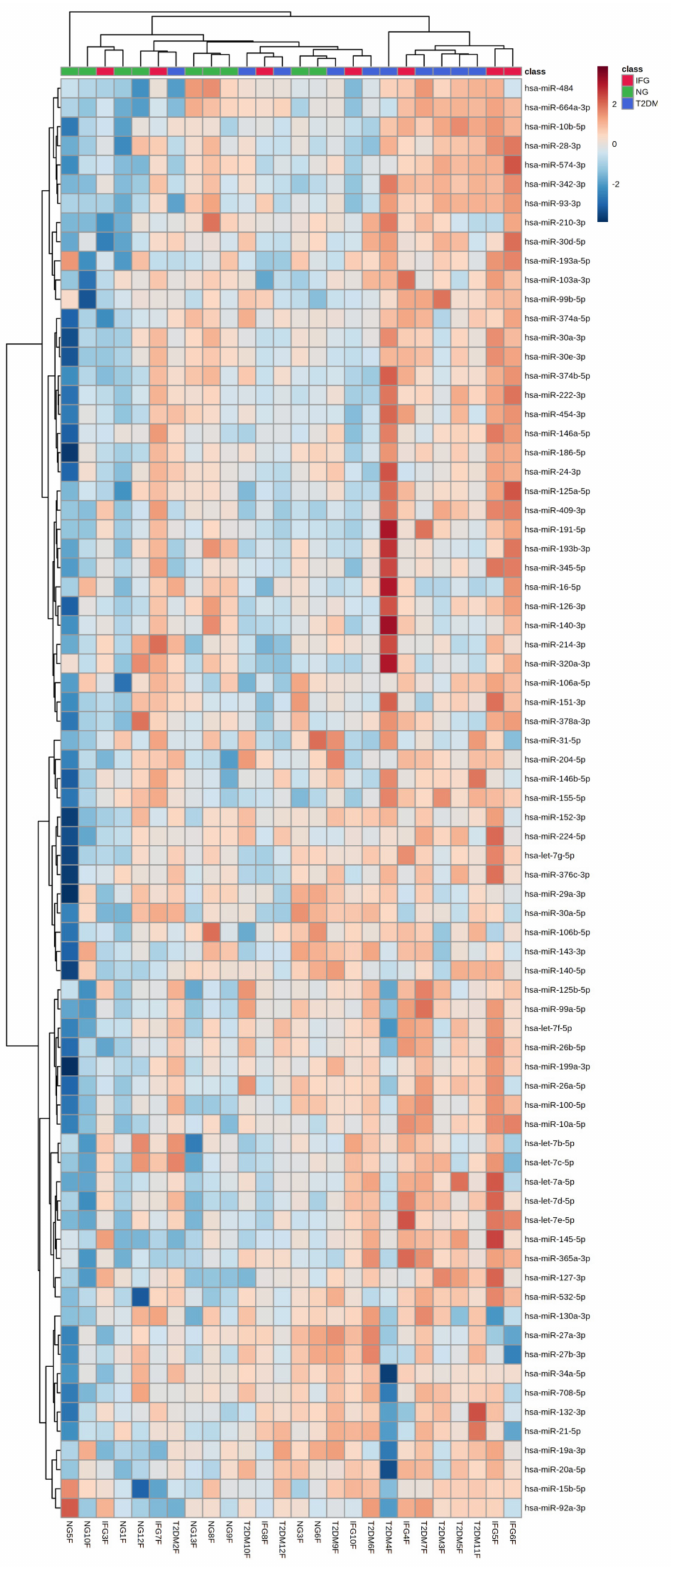
Figure 9. Euclidean hierarchical clustering among each female NG, IFG, T2DM subject (N = 26) and all tested